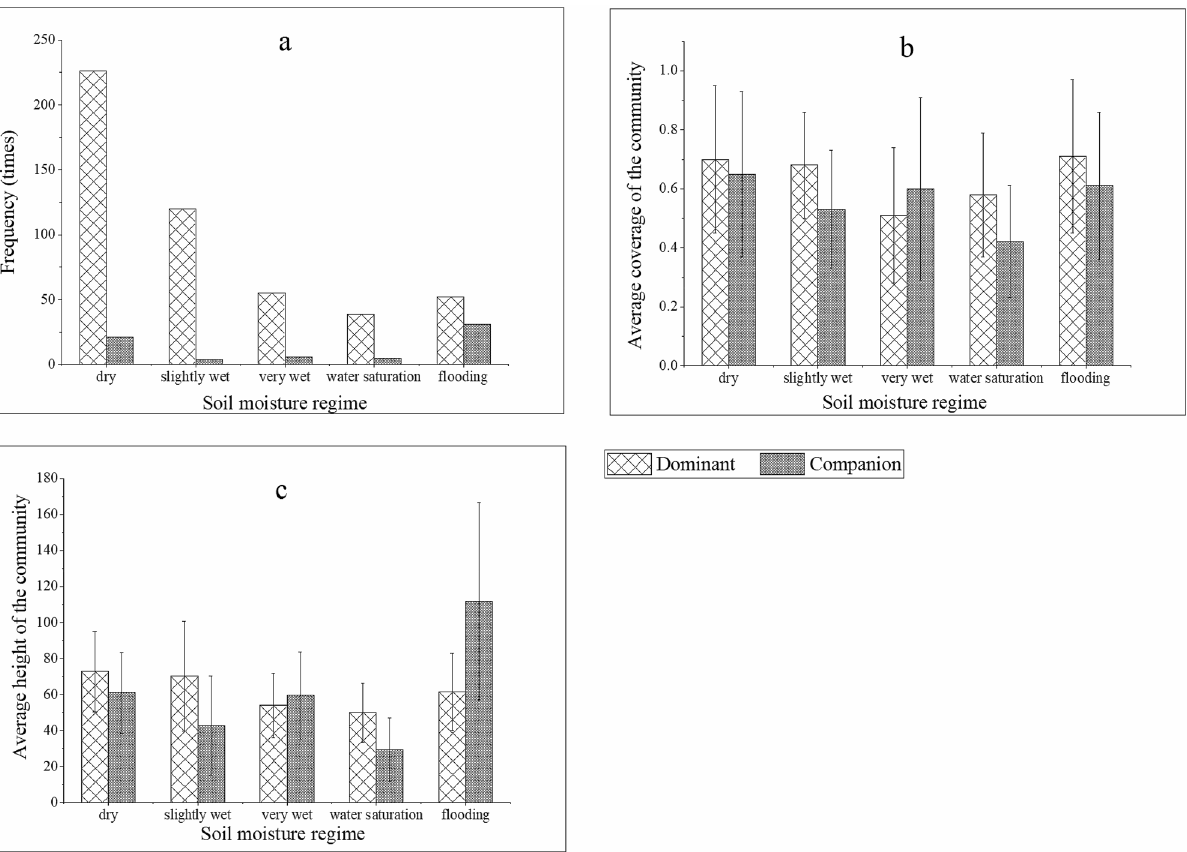
Figure 9. Characteristics of C. cinerascens population changes with soil moisture regime. ( a ) Frequency of the C. cinerascens population. ( b ) Coverage of the C. cinerascens population. ( c ) Average height of the C. cinerascens